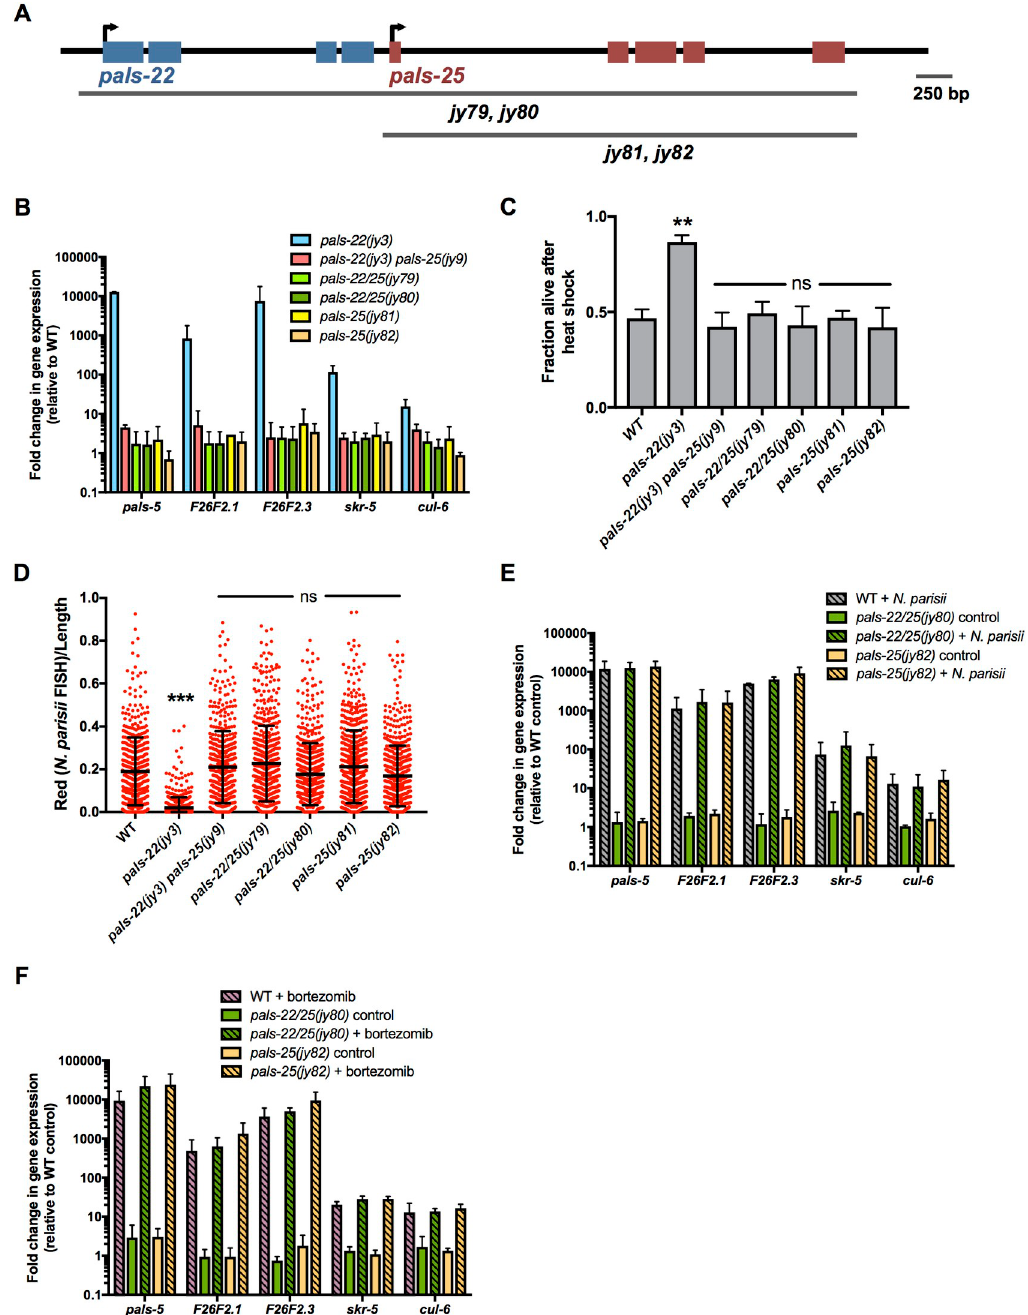
Fig 5. A complete deletion of the pals-25 gene and of the pals-22/25 locus leads to wild-type phenotypes. (A) pals-22 and pals-25 gene coding structure (UTRs not shown), with blue exons for pals-22 and red exons for pals-25 . Deleted regions are indicated; see S1 Table for more information. (B) qRT-PCR measurement of gene expression, shown as the fold change relative to wild-type control. (C) Survival of animals after 2 hour heat shock treatment at 37˚C followed by 24 hours at 20˚C. Strains were tested in triplicate, with at least 30 animals per plate. Assay was repeated three independent times with similar results, and data from a representative experiment are shown. Mean fraction alive indicates the average survival among the triplicates, errors bars are SD. �� p < 0.01, ns, not significant with Student’s t-test as compared to wild-type control. (D) N . parisii FISH signal quantified using a COPAS Biosort machine to measure the mean red signal normalized by length of individual animals, indicated by red dots. Mean signal of the population is indicated by black bars, with error bars as SD. Graph is a compilation of three independent replicates, with at least 100 animals analyzed in each replicate. ��� p < 0.001, ns, not significant